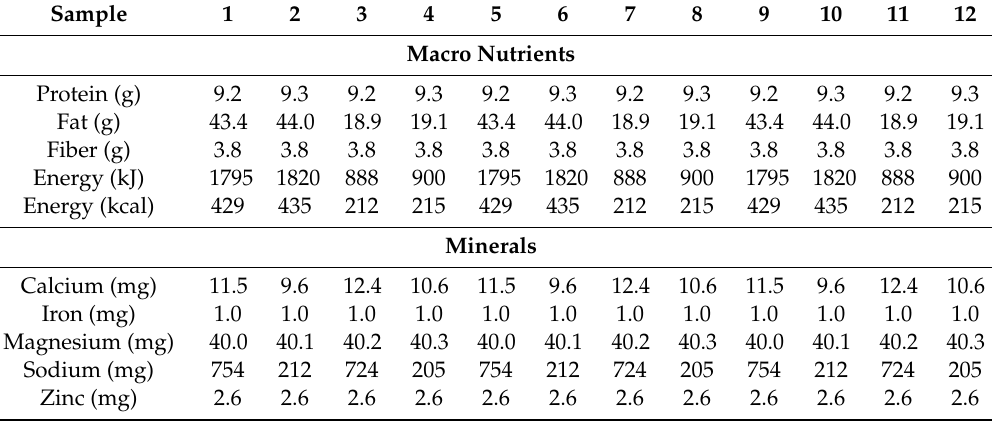
Table 3. Calculated nutritional content per 100 g sample (calculations on mealworms larvae was based on Finke, 2002 [30] and performed in Software Dietist Net, Kost och Näringsdata, Sweden).